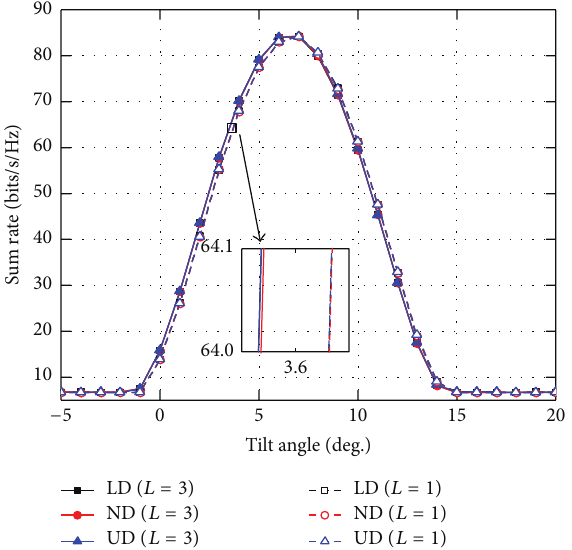
Figure 8: Simulated sum rate against the tilt angle for three user distributions ( 𝑝 𝑢 = 5 dB, 𝑁 𝑟 = 50 , 𝑁 𝑡 = 1 , 𝐿 = 1, 3 , 𝐾 = 42 , 𝐷 = 1000 m, 𝑅 = 100 m, 𝜐 = 4 , UD: uniform distribution, ND: normal distribution, and LD: linear